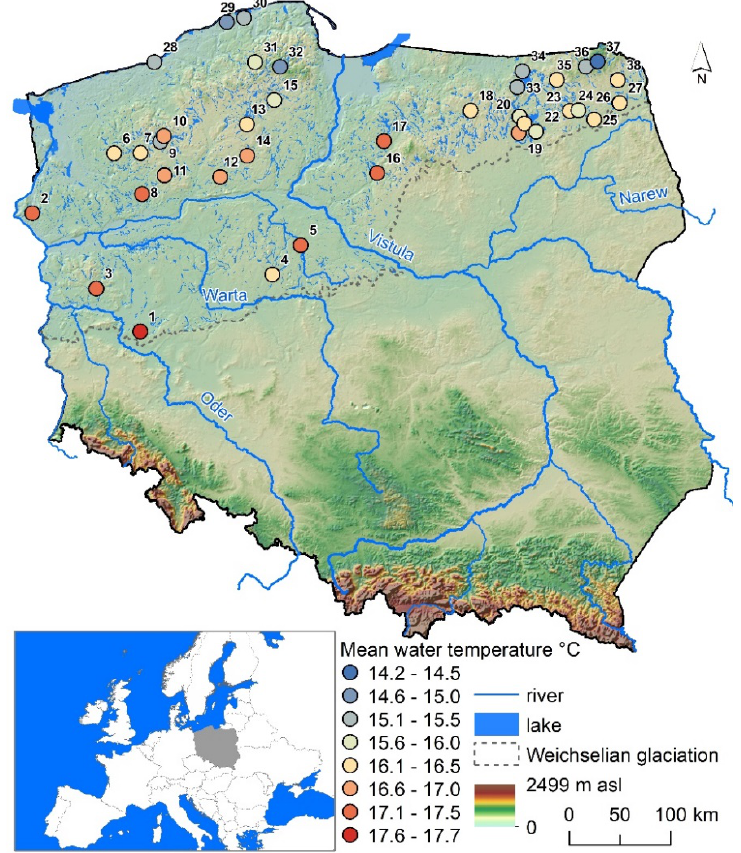
Figure 2. Location of the studied lakes with average water temperature from April to October. Numbering of lakes (1–38) according to Supplementary Table S1.